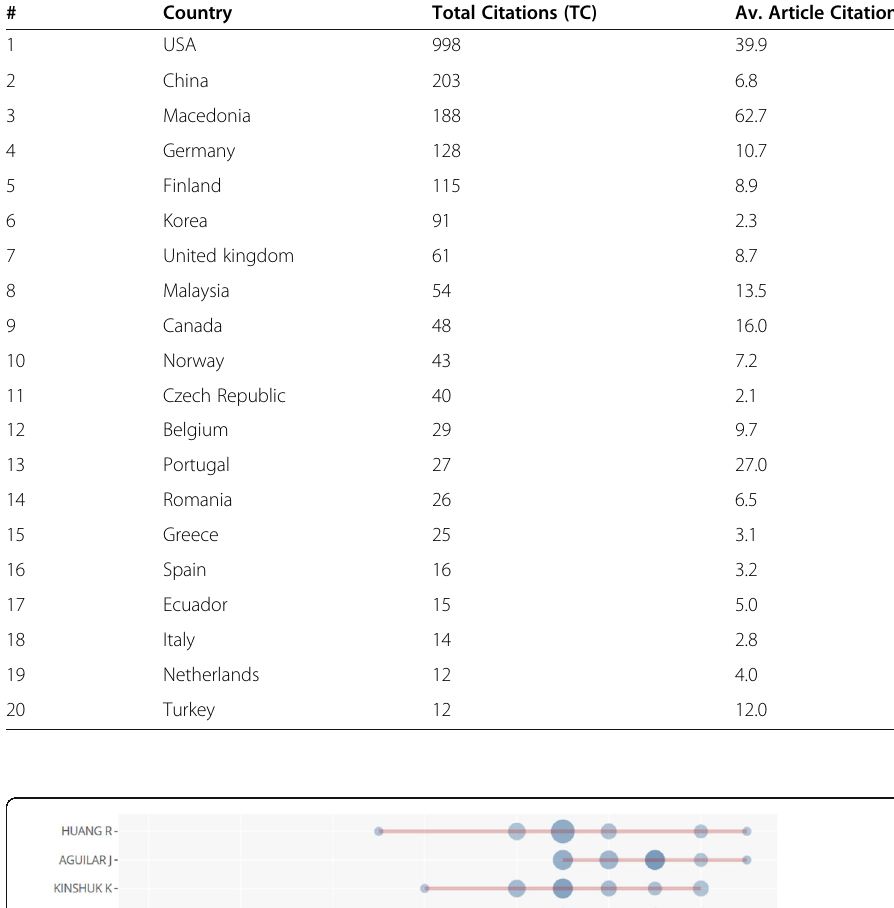
Table 6 Top twenty most cited countries in the field of smart learning environment